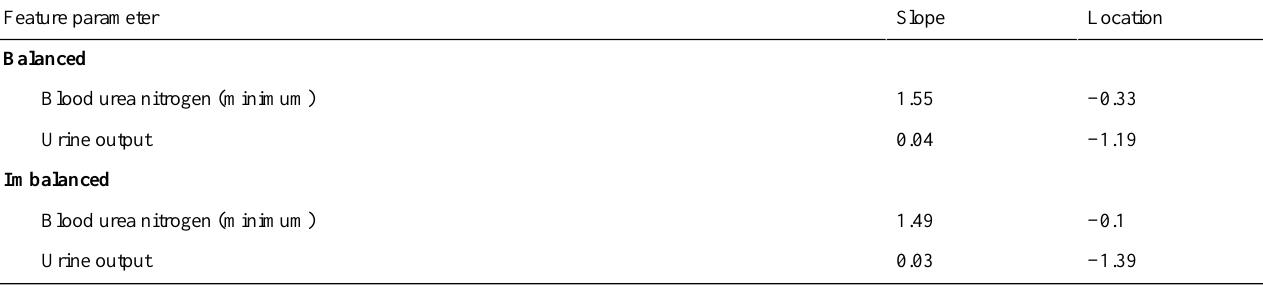
Table 5. Electronic intensive care unit feature